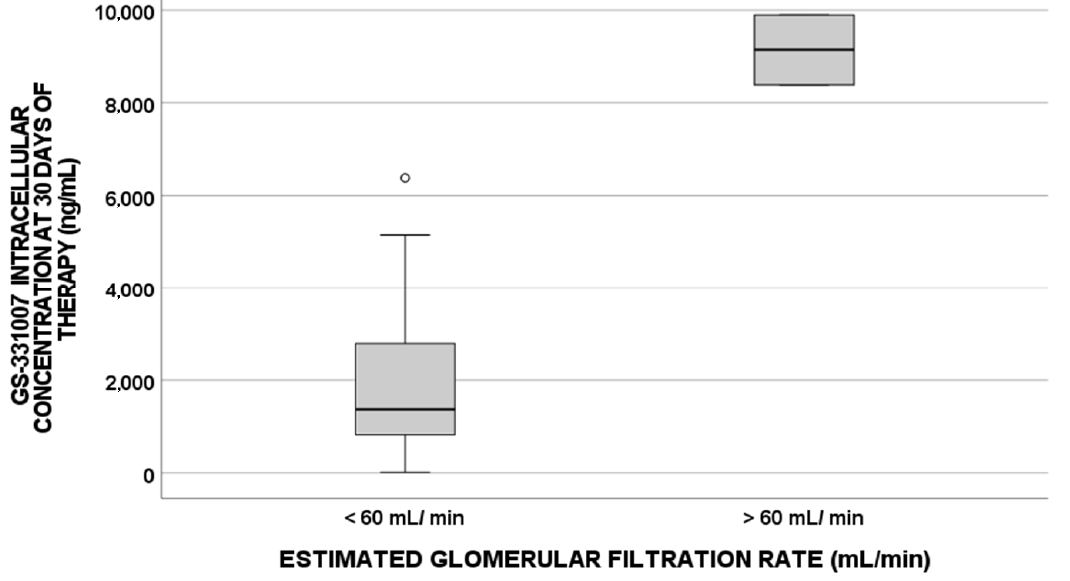
Figure 3. GS-331007 IC levels at 30 days of therapy correlated with the baseline estimated glomeru- lar filtration rate cutoff value of 60 mL/min ( p -value = 0.018, N = 48 for >60 mL/min; N = 2 for <60 mL/min).